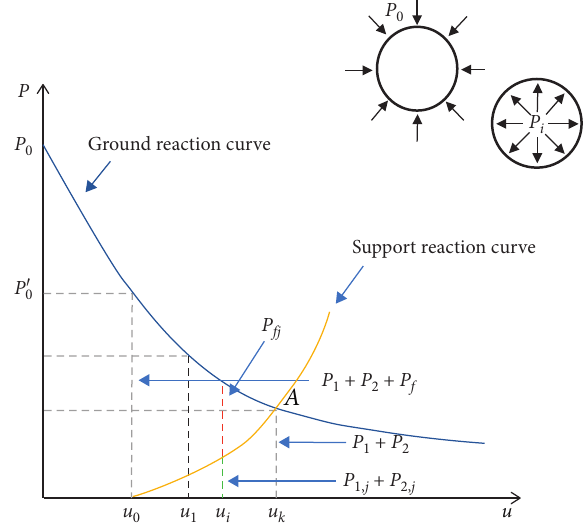
Figure 1: Ground reaction curve and suppose reaction